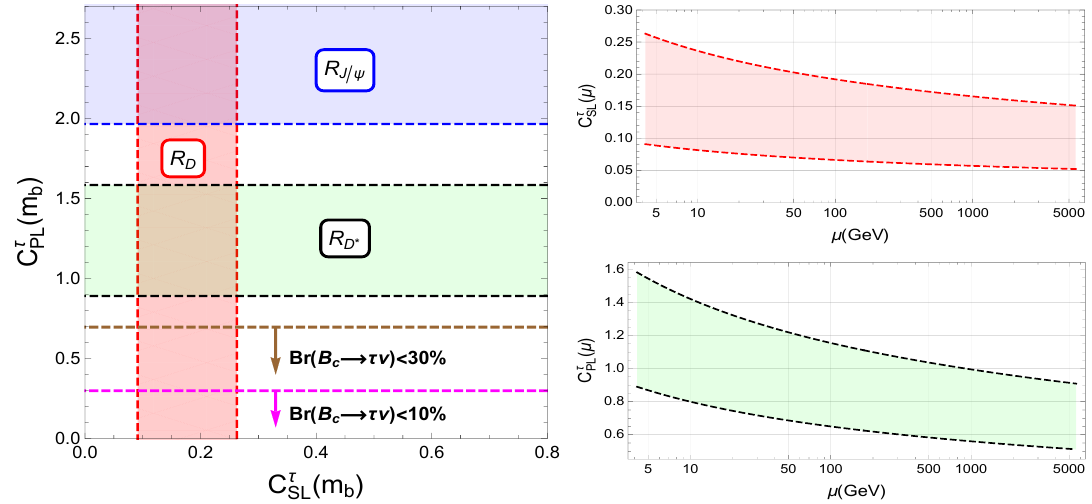
Figure 2 . Left panel : the red and green (blue) bands correspond to the values of C (cid:28) that satisfy the experimental measurement of R D and R D (cid:3) ( R values of C (cid:28) that correspond to Br( B c ! (cid:28)(cid:23) ) < 30% and < 10% are also shown. Right panel : PL renormalisation group running of the WCs C (cid:28)